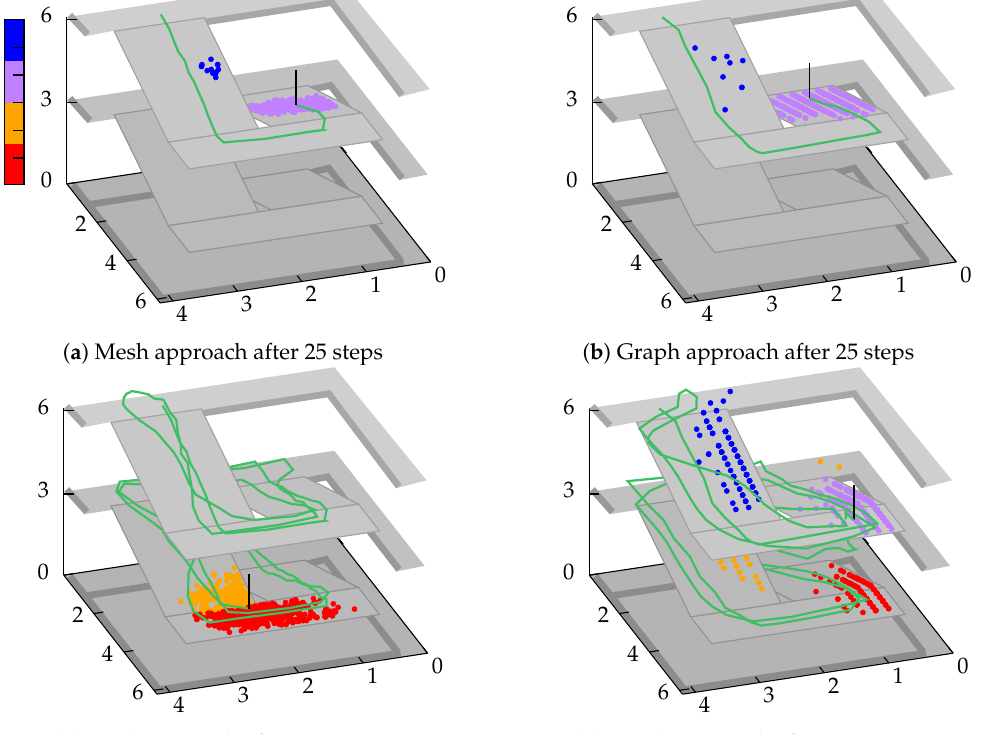
Figure 6. Simple staircase scenario to compare the old graph-based model with the new navigation mesh. All units are given in meter. The black line indicates the current position and the green line gives the estimated path until 25 or 180 steps, both using weighted average. The particles are colored according to their z -coordinate. A pedestrian walks up and down the stairs several times in a row. After 25 steps, both methods produce good results, although there are already some outliers (blue particles). After 180 steps, the outliers using the graph have multiplied, leading to a multimodal situation. In contrast, the mesh offers the possibility to remove particles that hit a wall and can thus prevent such a